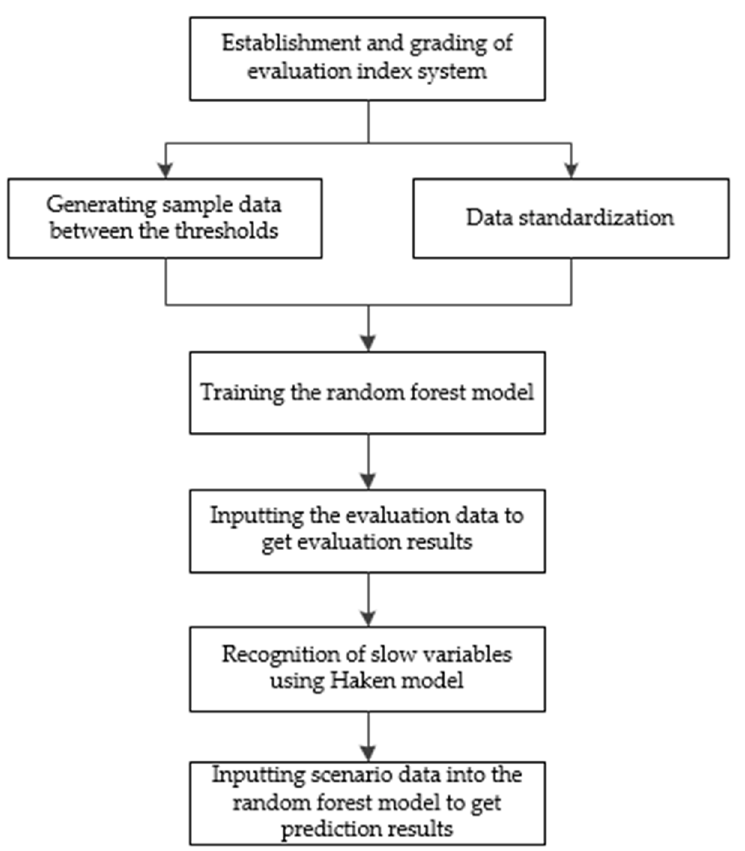
Figure 2. Flow chart of water-energy-food system security evaluation.